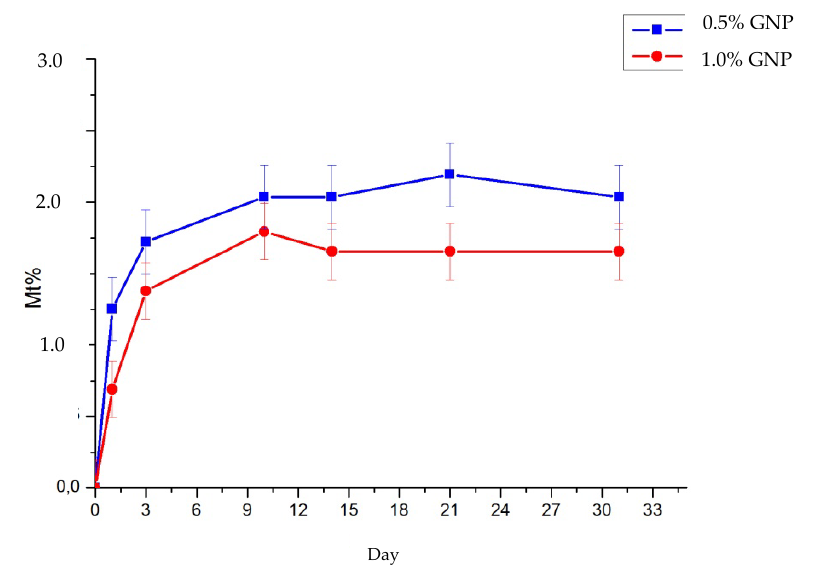
Figure 16. Mass trend for thin films at 2000 rpm and 5000 rpm with 0.25% GNP .